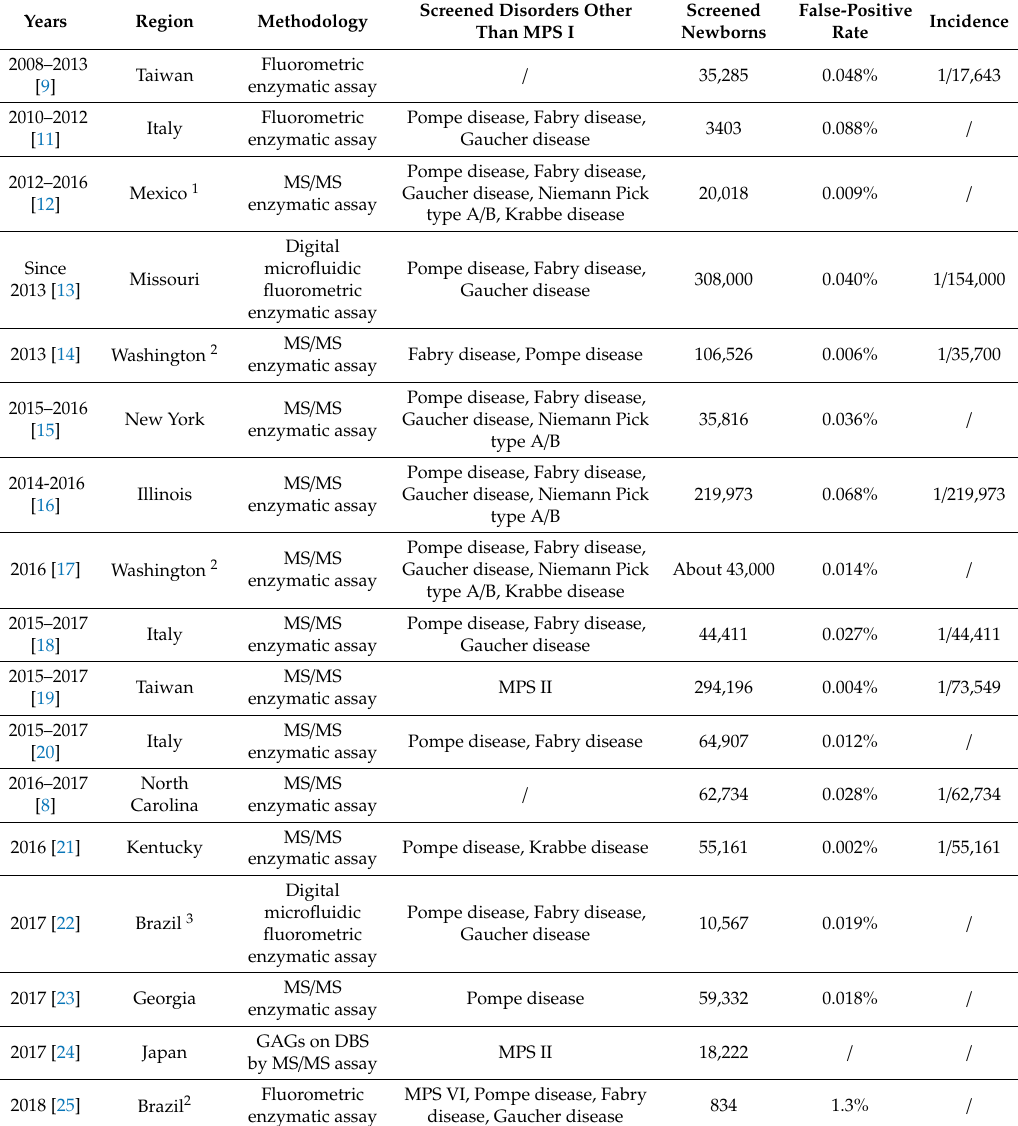
Table 1. Worldwide newborn screening for Mucopolysaccharidosis type I (MPS